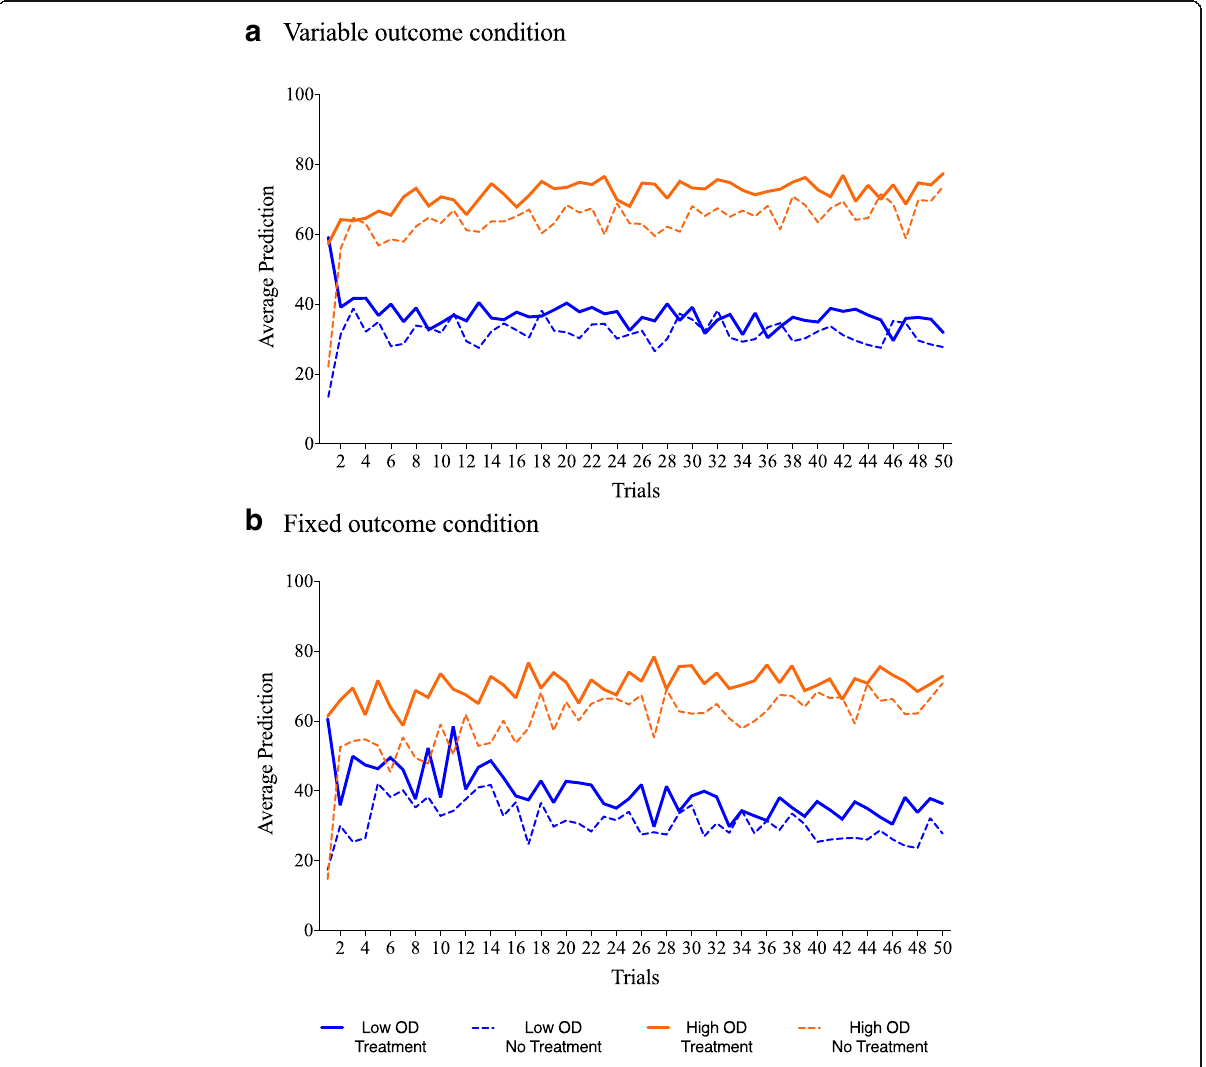
Fig. 4 a Average predictions during training as a function of OD (low vs. high) and cue type (treatment vs. no treatment) for participants in the variable outcome condition. b Average predictions during training as a function of OD and cue type for participants in the fixed outcome condition. OD outcome